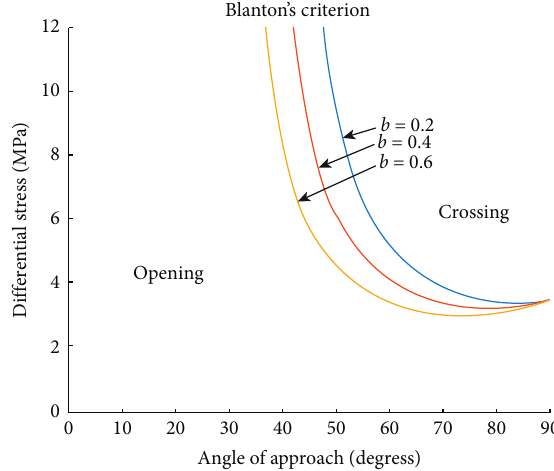
Figure 2: The chart of Blanton’s criterion.